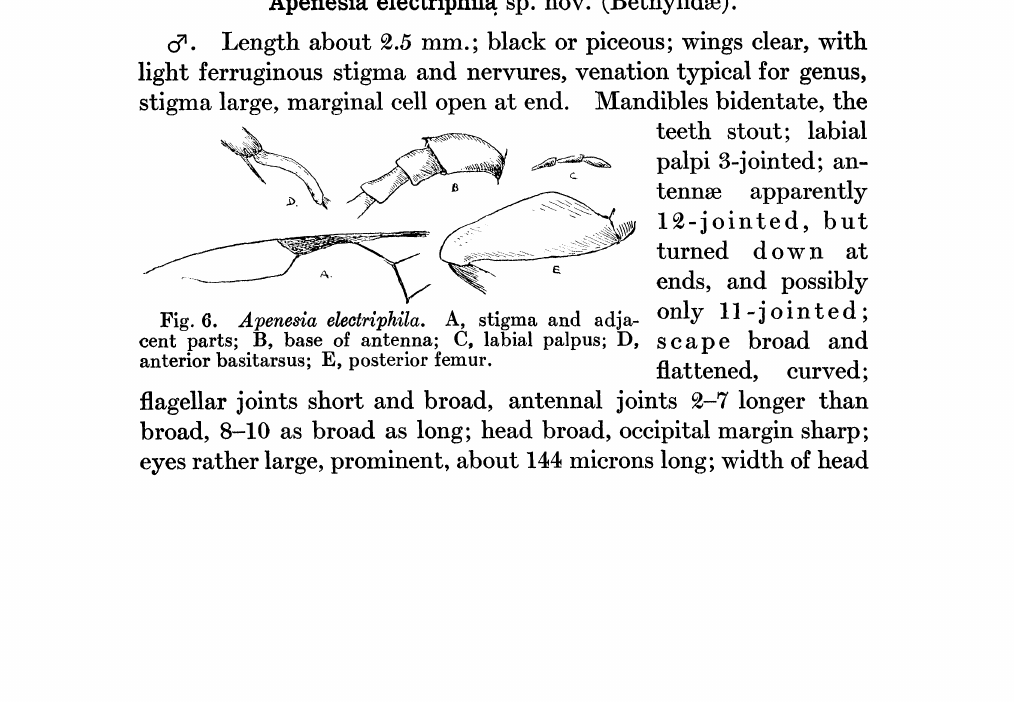
only 11 o n t e d Fig. 6. Apenesla electriphila. A, stigma and adja- cent parts; B, base of antenna; C, labial palpus; D, scape broad and anterior basitarsus; E, posterior femur, flattened,